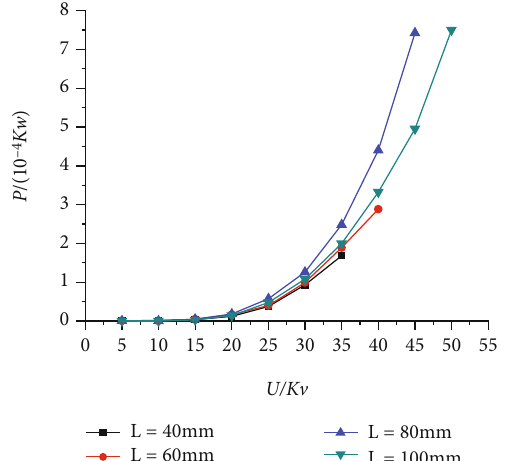
Figure 12: Burr numbers in fl uence on dust removal e ffi